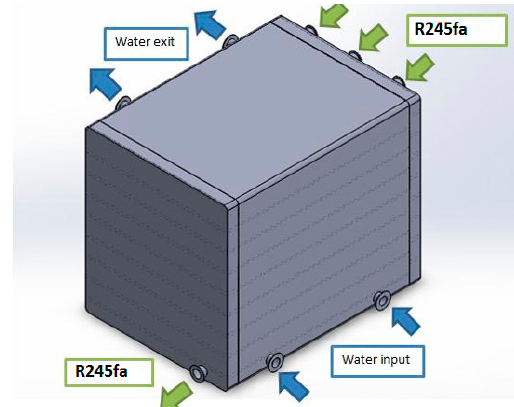
Figure 8. Condenser 3D assembled view.